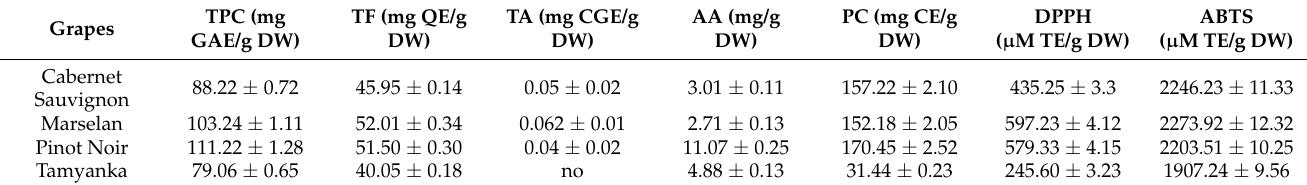
Table 2. Spectrophotometric determination of phenolic composition and antioxidant capacity of grape seed